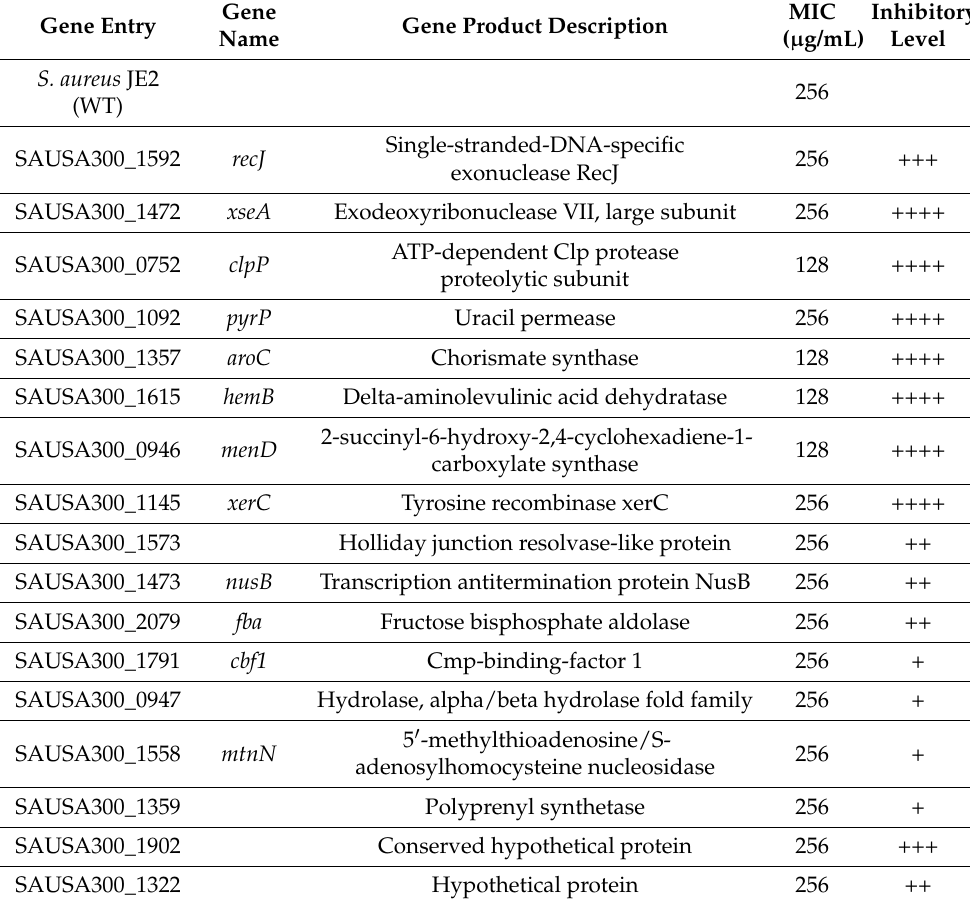
Table 2. Screened out genes with increased susceptibility towards resveratrol. Gene